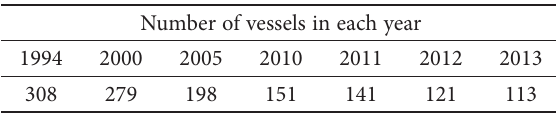
Table 1. Decrease of the Lithuanian fleet Number of vessels in each